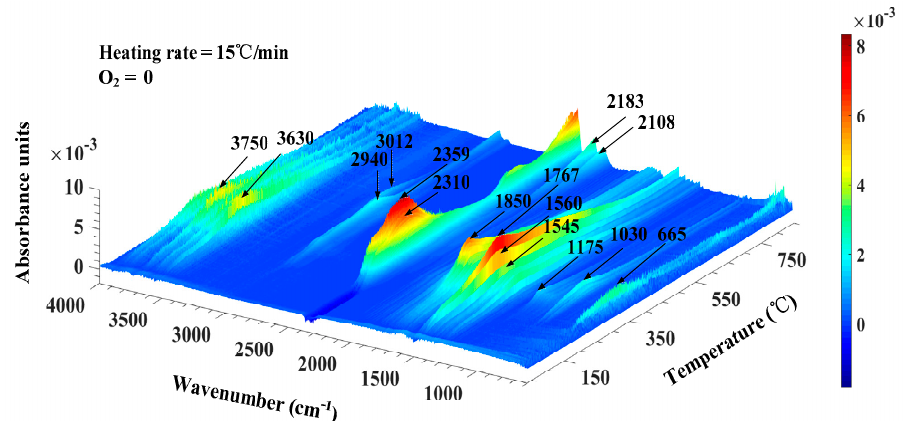
Figure 4. Evolution of the production of different products for pyrolysis of sewage sludge measured by Fourier transform infrared (FTIR) spectroscopy.